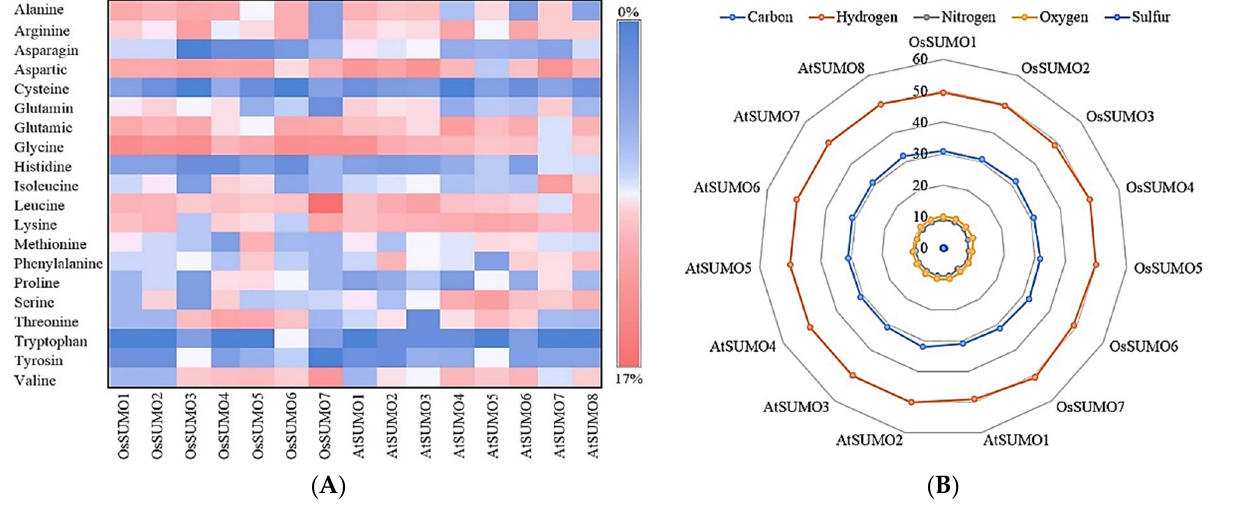
Figure 4. ( A ) Heatmap presentation of OsSUMOs’ and AtSUMOs’ composition of amino acid by percentage. The common amino acid present in all SUMOs is shown. ( B ) Radar graph for atomic composition percentage (number of each atom by number of total atoms) of OsSUMOs and AtSUMOs.